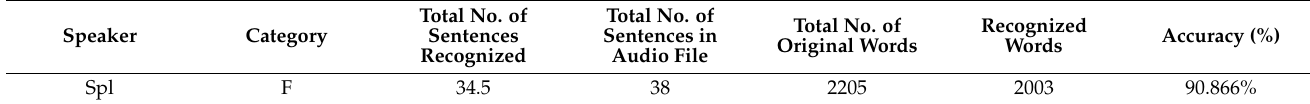
Figure 6. Graphical overview for accuracy level of 11 speakers in current ASR system. Table 5. Speaker 1 details.